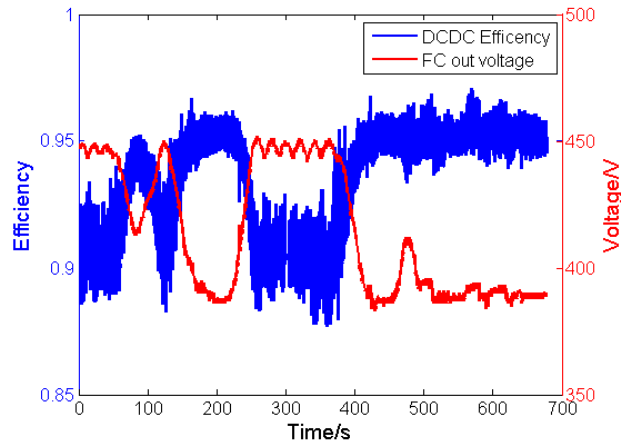
Figure 16. The relationship between stack voltage and DC/DC efficiency.